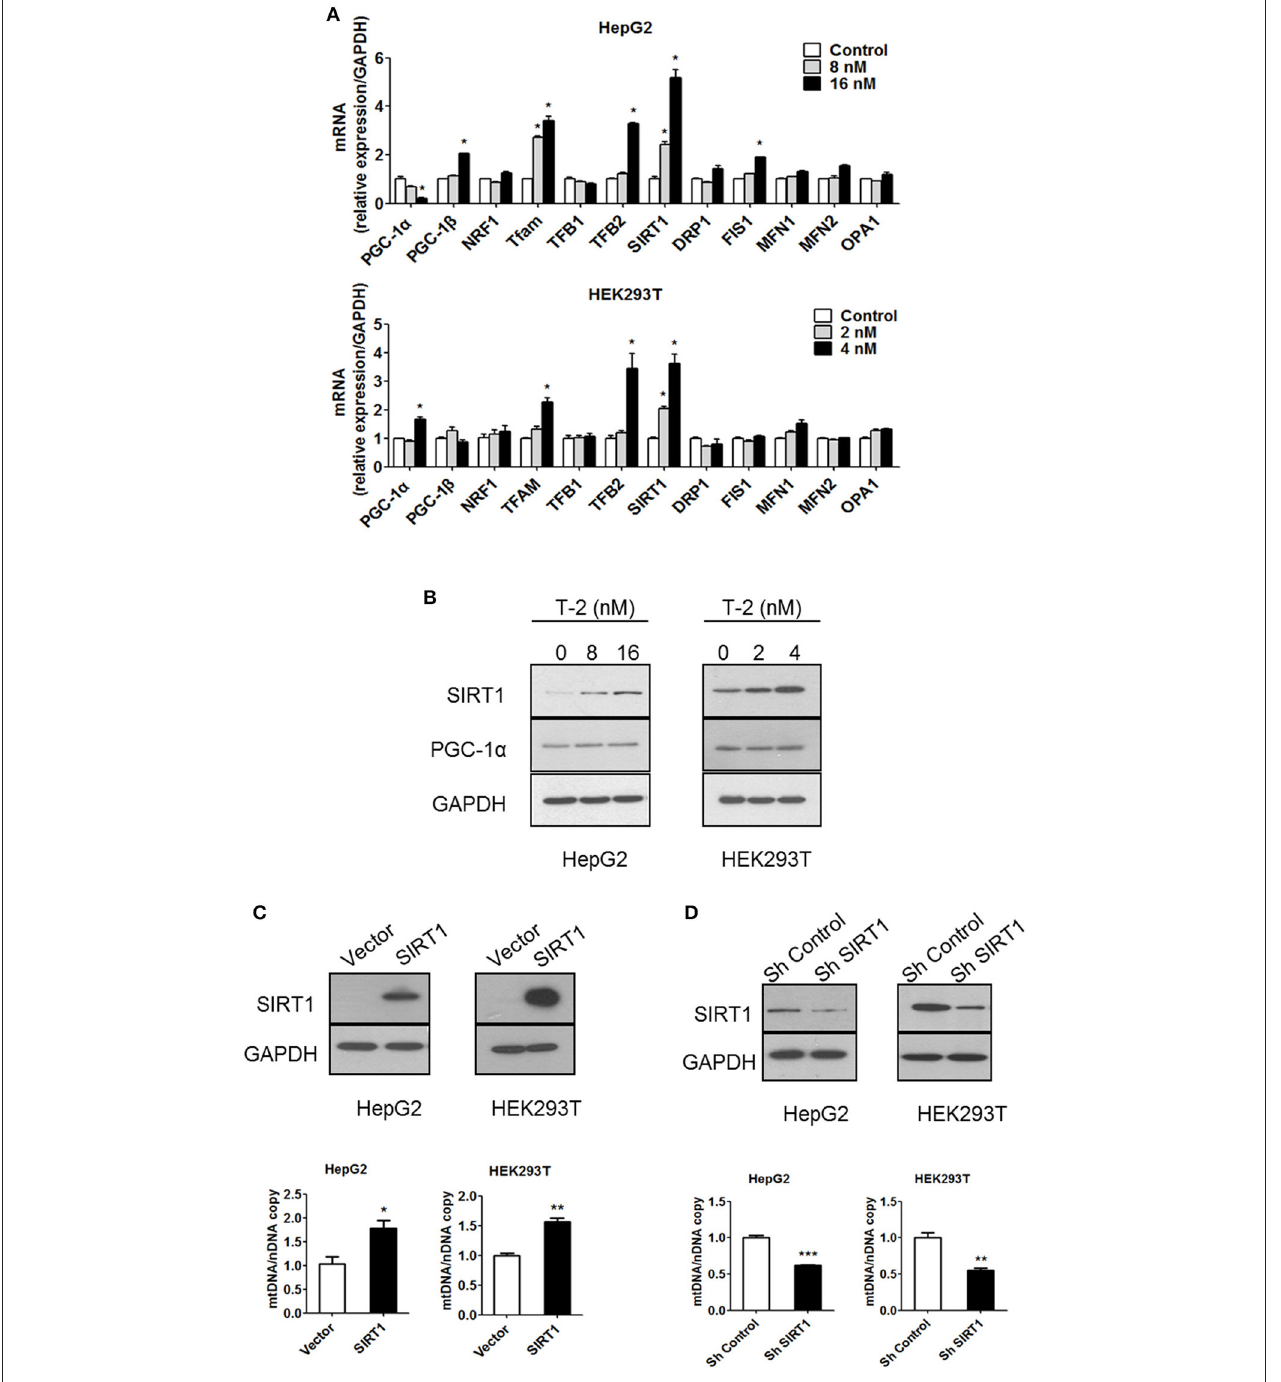
FIGURE 3 | Low-dose exposure to T-2 toxin enhanced the mRNA and protein levels of SIRT1 in HepG2 and HEK293T cells. (A) PGC-1 α , PGC-1 β , NRF1, TFAM, TFB1, TFB2, SIRT1, DRP1, FIS1, MFN1, MFN2, and OPA1 mRNA levels in HepG2 (top) and HEK293T cells (bottom panel) were analyzed by RT-qPCR after T-2 toxin exposure at different doses. All the tested mRNA levels were normalized by the GAPDH mRNA level as the internal control. The experiments were repeated at least three times. (B) The protein levels of SIRT1, PGC-1 α , and GAPDH in HepG2 (Left) and HEK293T cells (Right) with or without T-2 toxin treatment were assayed by western blotting with antibodies against SIRT1, PGC-1 α , and GAPDH, respectively. The results shown are representative of three independent experiments. (C) SIRT1 expression level in HepG2 and HEK293T cells overexpressing SIRT1 was analyzed by western blotting. Mitochondrial DNA content in HepG2 and HEK293T cells overexpressing SIRT1 analyzed by RT-qPCR. (D) SIRT1 expression level in HepG2 and HEK293T cells infected with SIRT1 or nontargeting shRNA was analyzed by western blotting. Mitochondrial DNA content in HepG2 and HEK293T cells stably transfected with SIRT1-specific shRNA or nontargeting shRNA was analyzed by RT-qPCR. Statistically significant differences are indicated by asterisks (* P < 0.05, ** P < 0.01, *** P < 0.001).